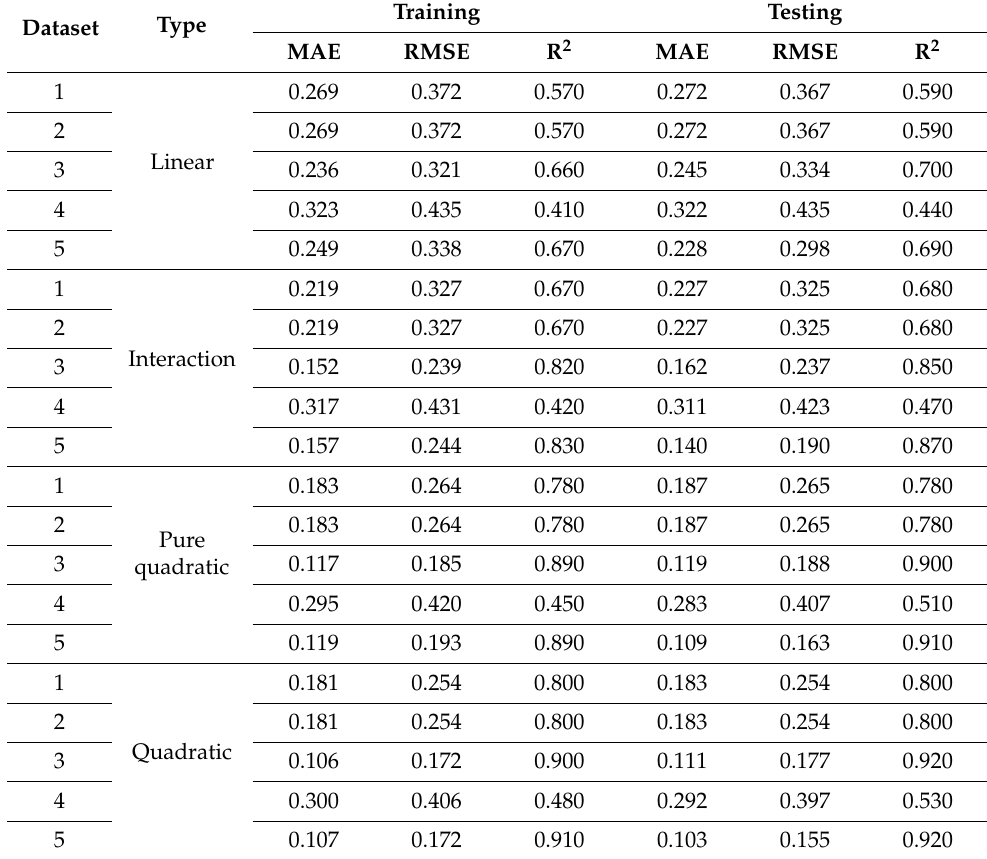
Table 7. MLR performance from different types of model specification during training and